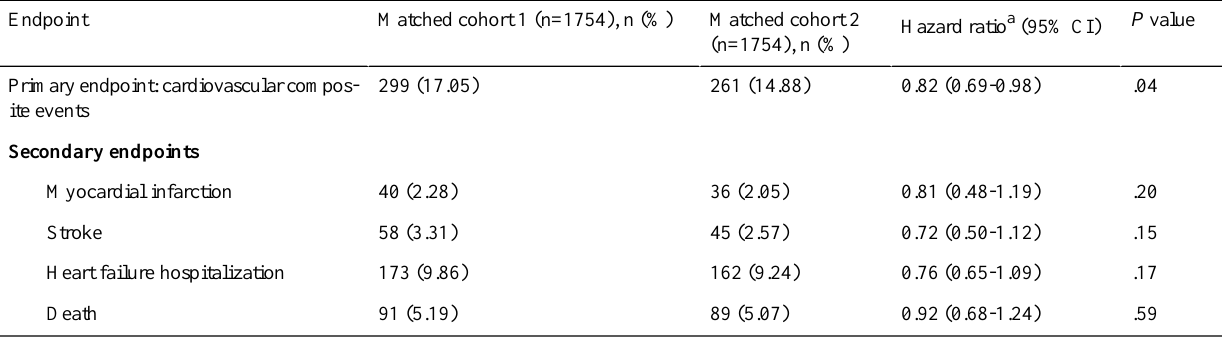
Table 2. Comparison of primary and secondary endpoints between the